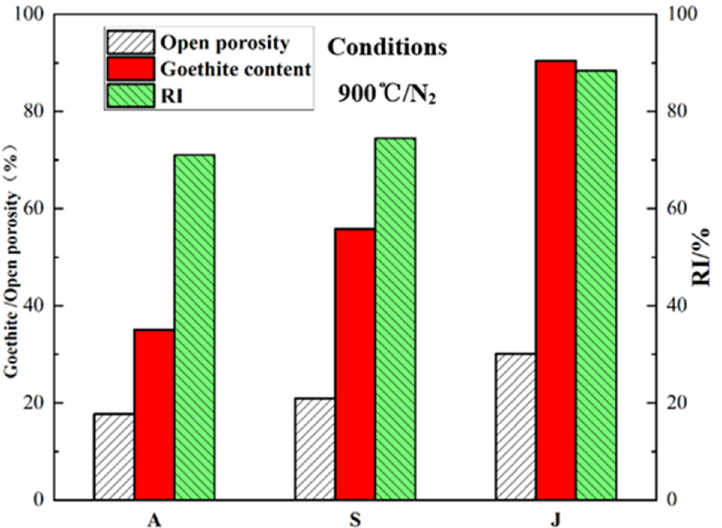
Figure 7. Relationship between the open porosity and the goethite content and the reducibility at high temperatures.